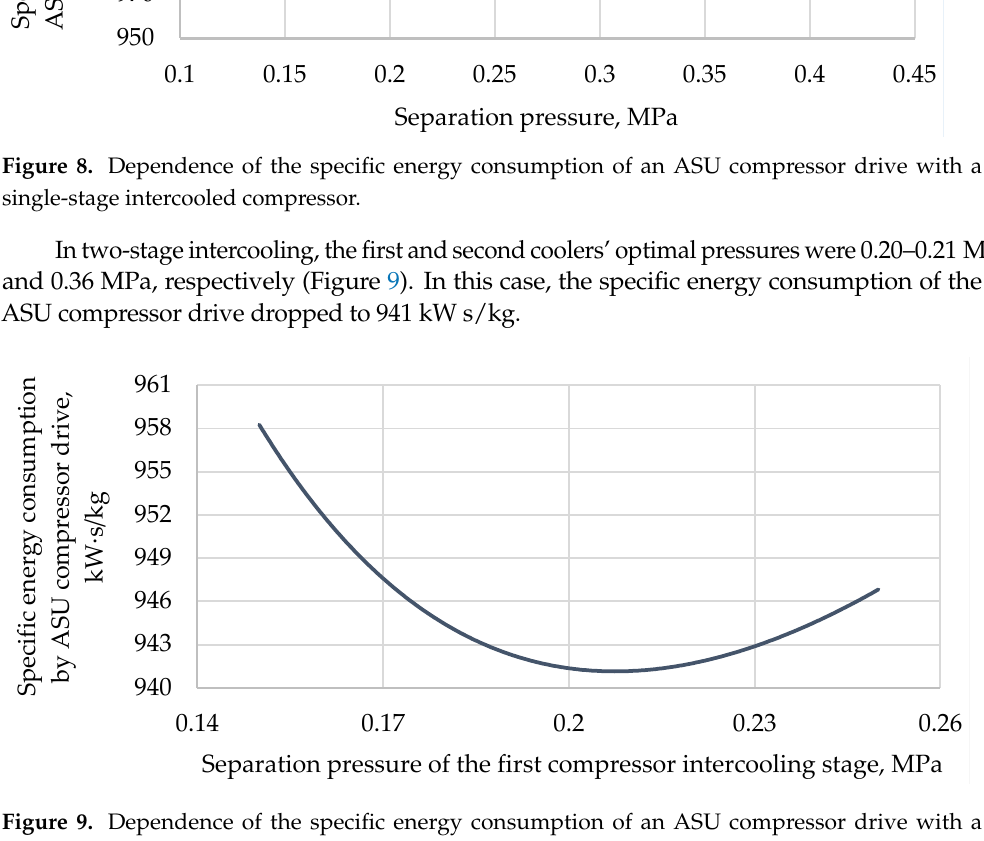
Figure 9. Dependence of the specific energy consumption of an ASU compressor drive with a two-stage intercooled compressor.